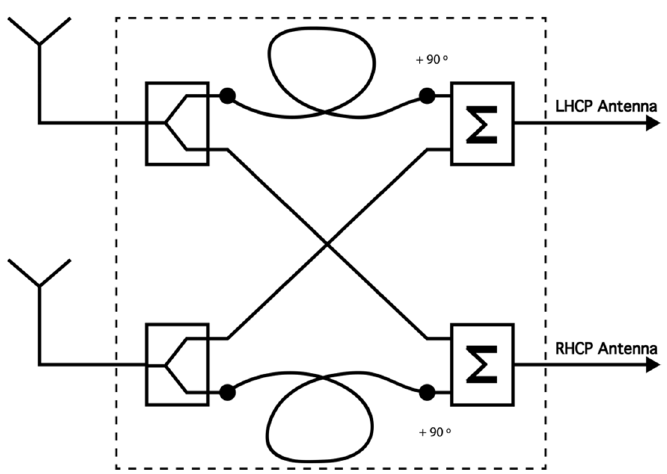
Figure 4. Block diagram of the phasing network.